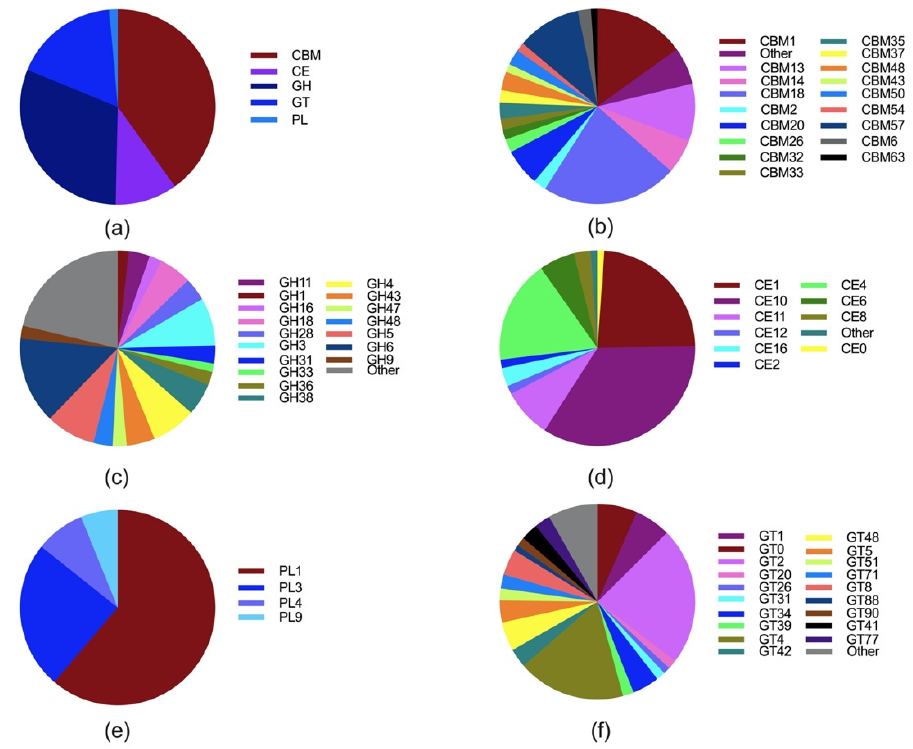
Figure 2. The CAZymes in anaerobic fungal strain Pecoramyces sp. F1. The identified complement of ( a ) CAZymes; ( b ) Carbohydrate binding modules (CBM); ( c ) glycoside hydrolases (GH); ( d ) Carbohydrate esterases (CE); ( e ) Polysaccharide lyases (PL); ( f ) Glycosyl transferases (GT).